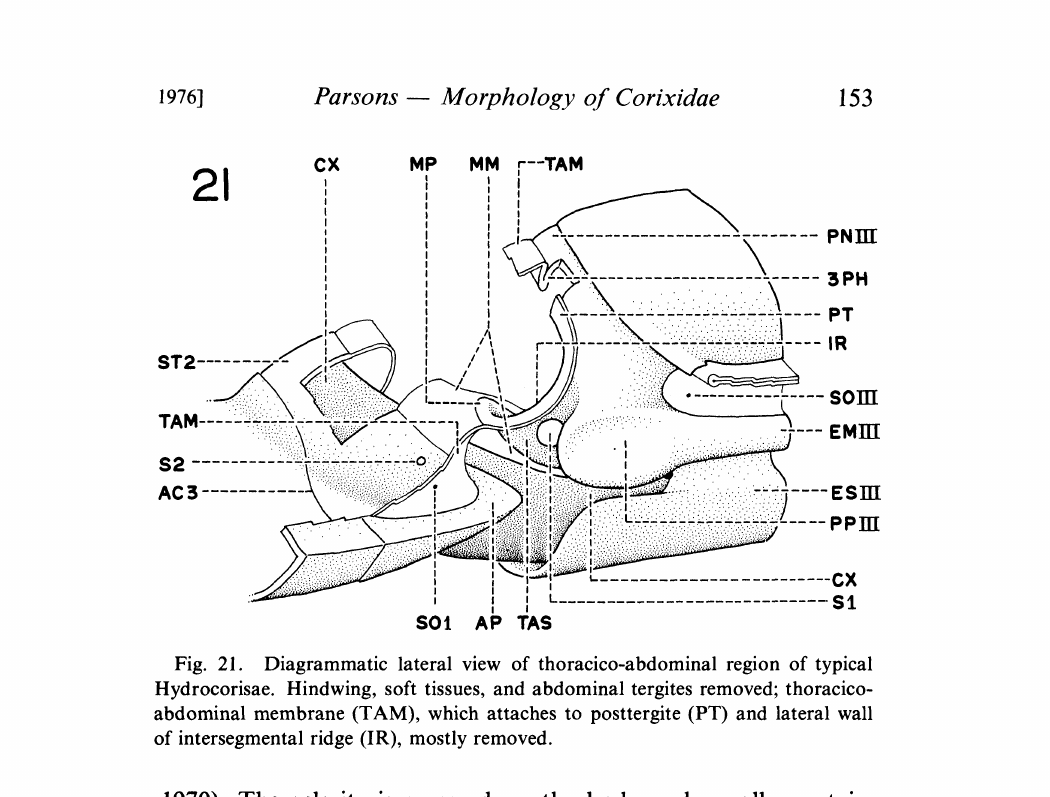
Fig. 21. Diagrammatic lateral view of thoracico-abdominal region of typical Hydrocorisae. Hindwing, soft tissues, and abdominal tergites removed; thoracico- abdominal membrane (TAM), which attaches to posttergite (PT) and lateral wall of intersegmental ridge (IR), mostly